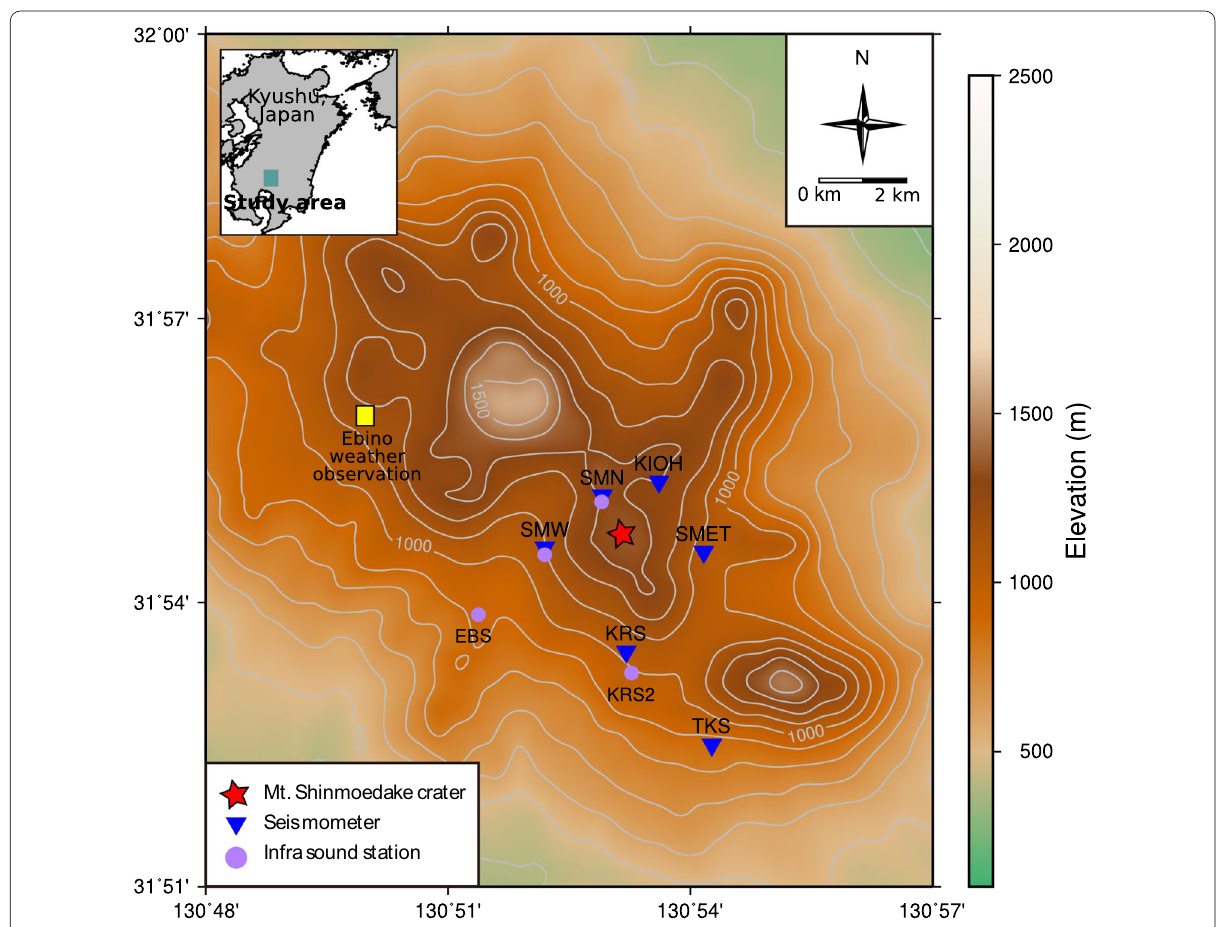
Fig. 1 Topographic map of Shinmoedake volcano also showing the locations of seismic, infrasound, and weather stations in the area that are used in this study. The small inset in the upper left corner displays a map of Kyushu island and the location of the Kirishima complex as a solid